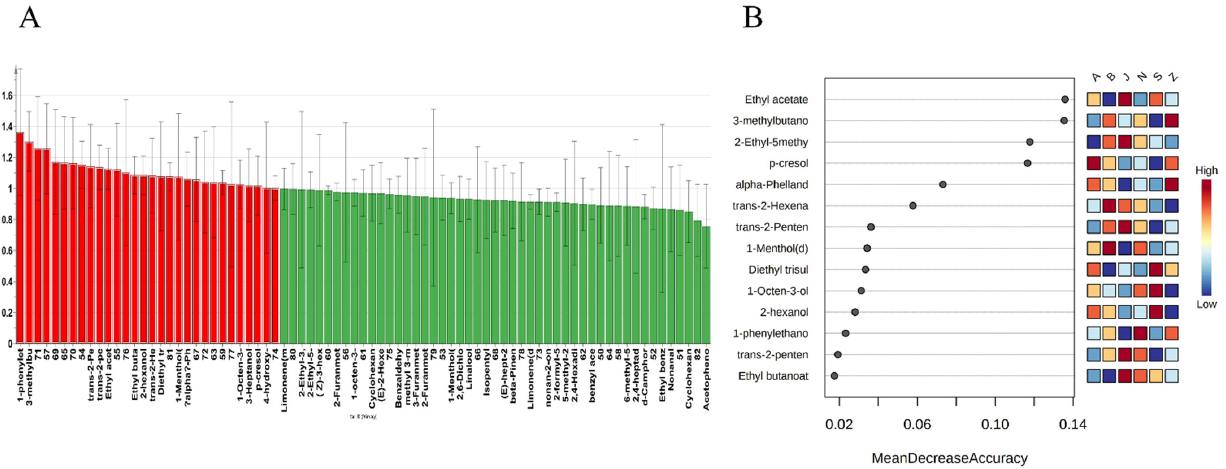
Figure 4. ( A ) Variable Importance for the Projection (VIP) diagram of the OPLS ‐ DA model; ( B ) significant features identified by random forest. ( B ) significant features identified by random